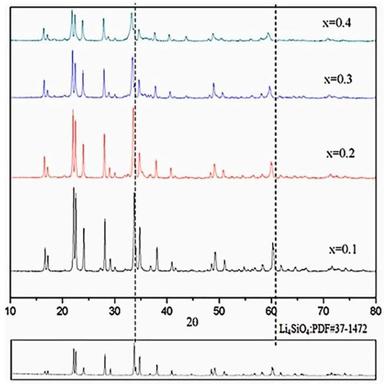
XRD patterns of the Li4Si1-xTixO4 powder samples fired at 900 ◦C for 10 h.